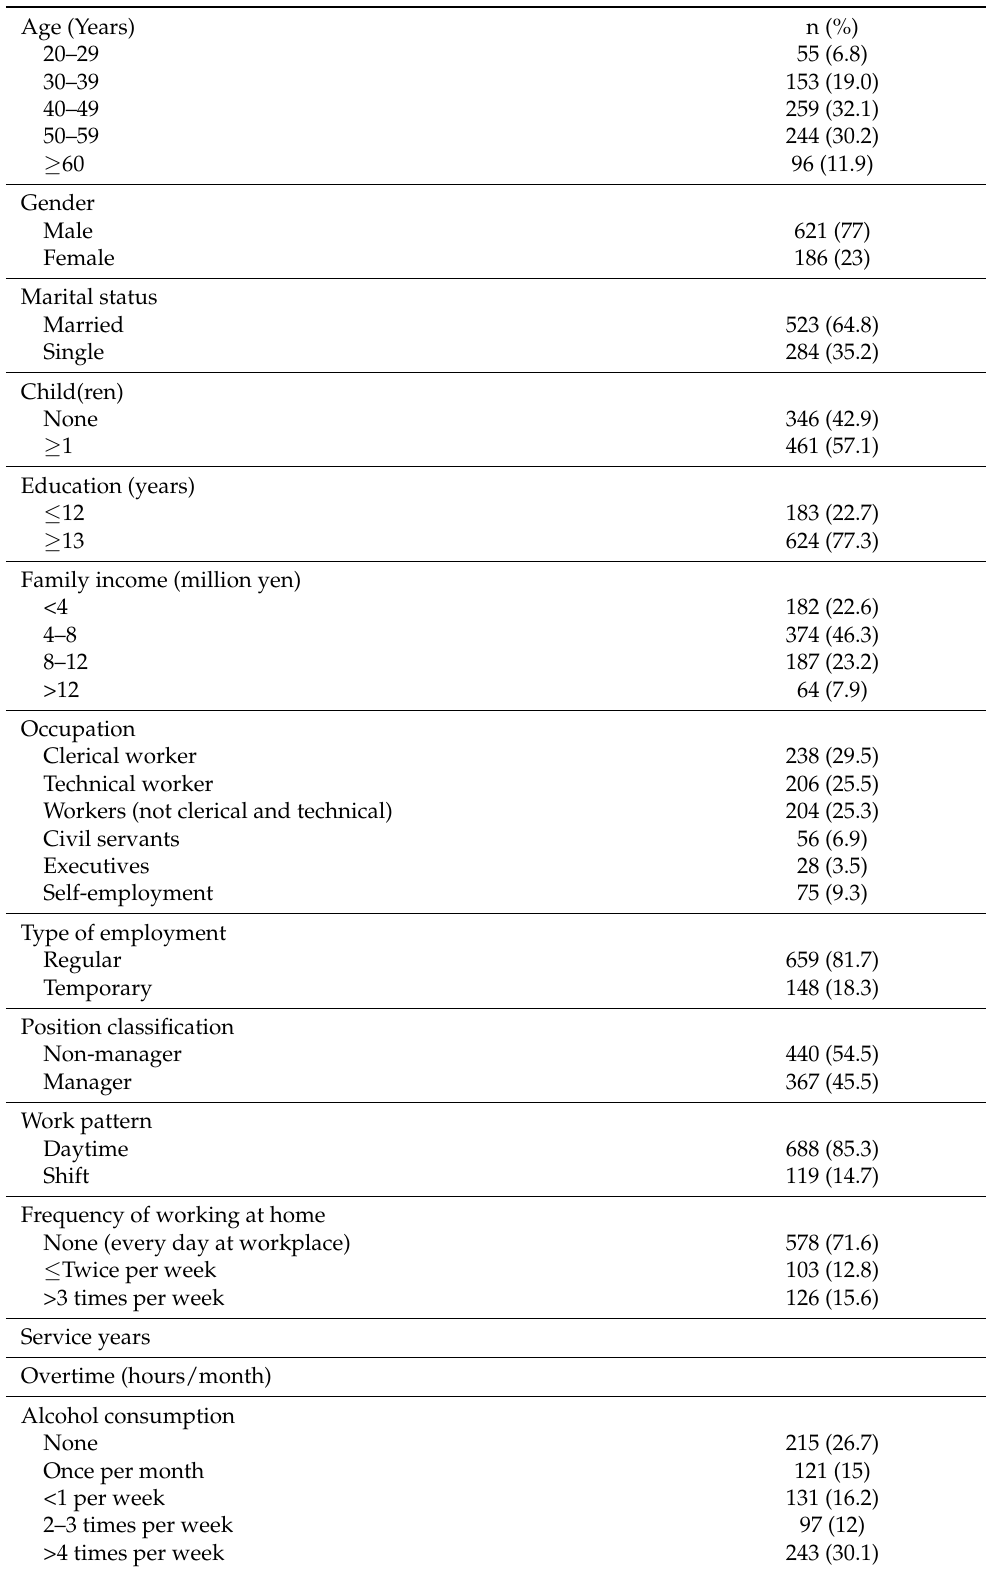
Table 1. Participants’ socio-demographic characteristics and work environment (N =